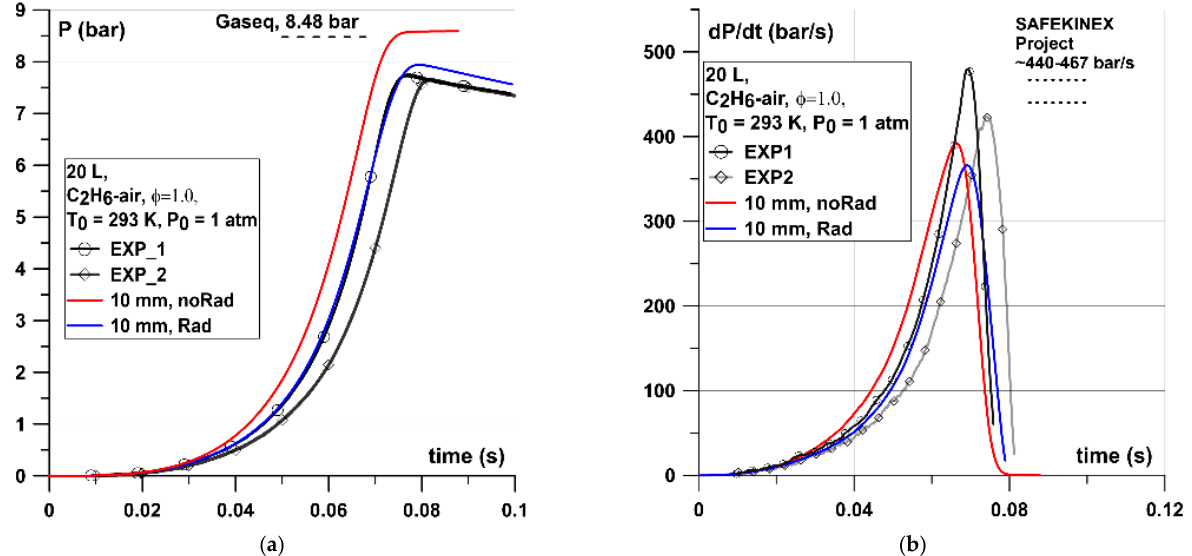
Figure 12. ( a ) Pressure and ( b ) dP/dt graphs for stoichiometric C 2 H 6 –air mixture in the 0.02 m 3 vessel.